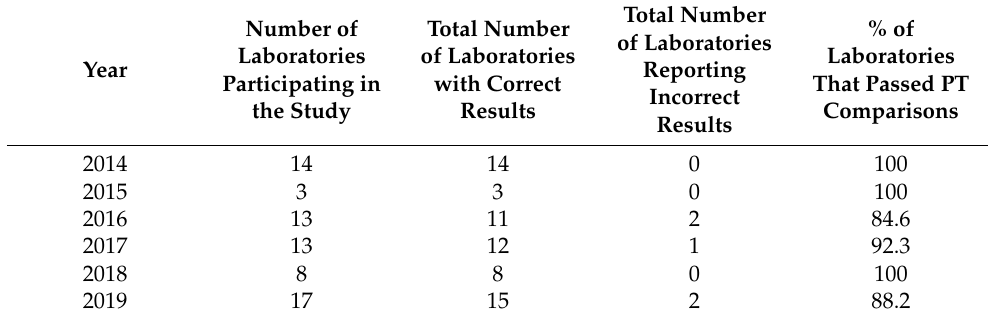
Table 3. Laboratory qualitative